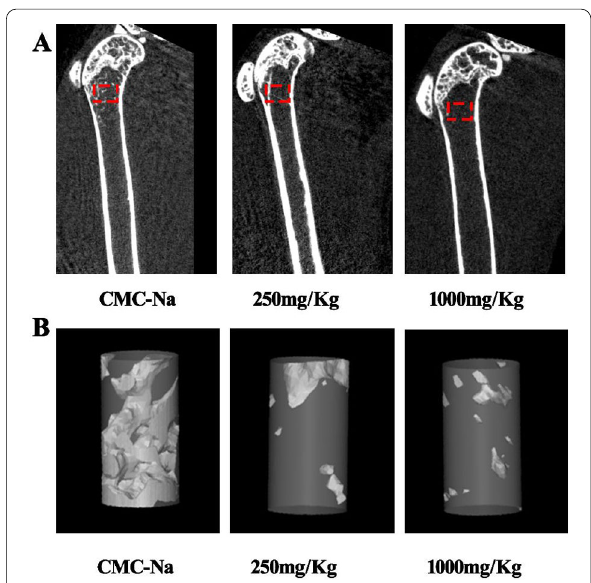
Fig. 2 Representative microcomputed tomography (micro-CT) images of the distal femurs. A Micro-CT images of femur specimens showed a reduction in trabecular bone microarchitecture after treatment with increasing doses of LPZ (red box). B Micro-CT images of cancellous bone structures near the growth plate (n